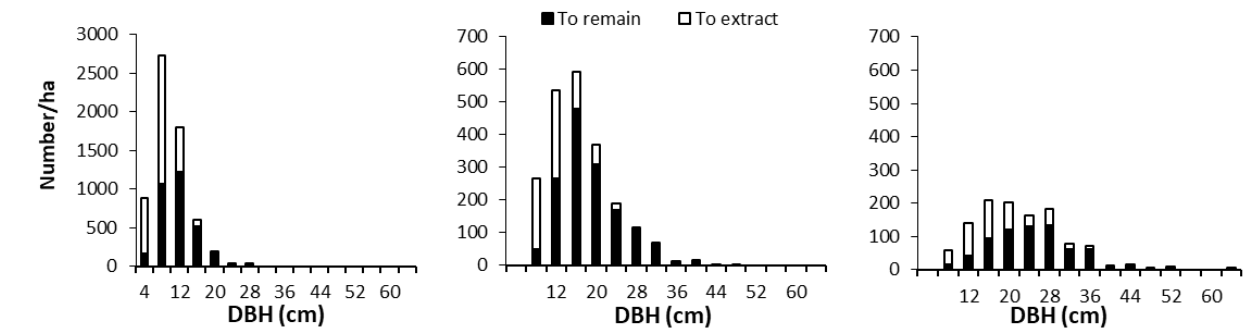
Figure 4. Height curve of the different structures.